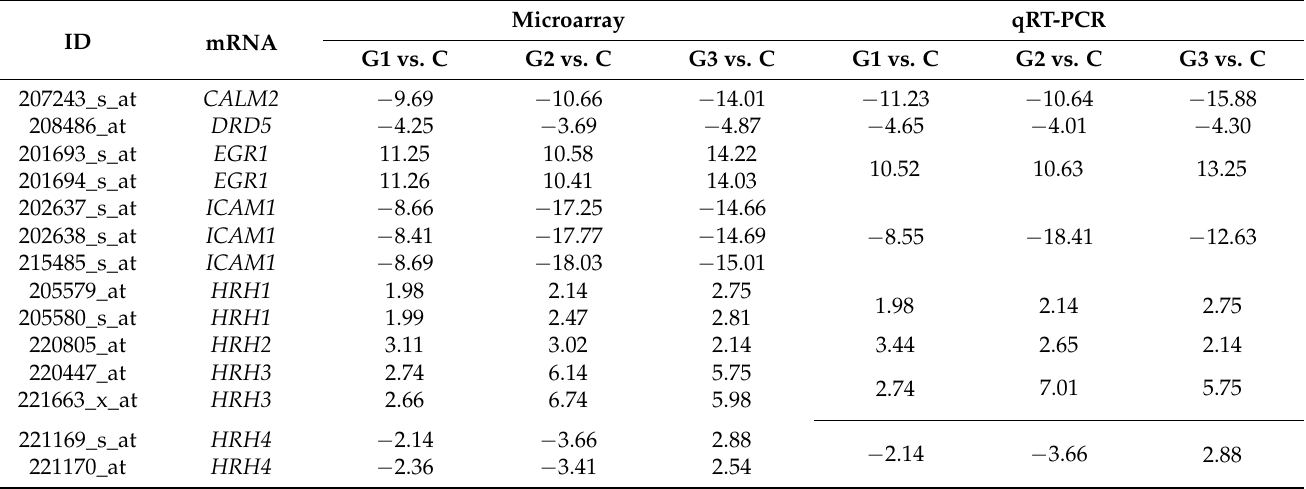
EGR1 , and ICAM1 in endometrial tissues was assessed with qRT-PCR. Table 1 summarizes shown as a fold change (FC). Table 1. Expression profile of selected biogenic amine-related genes in endometrial tissue samples determined by microarrays and qRT-PCR ( p < 0.05).